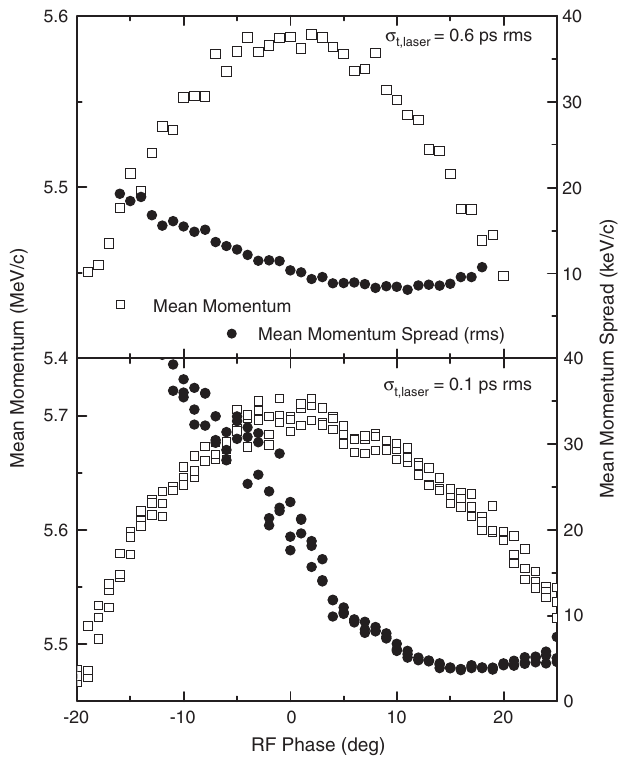
FIG. 8. Momentum and momentum spread versus the rf